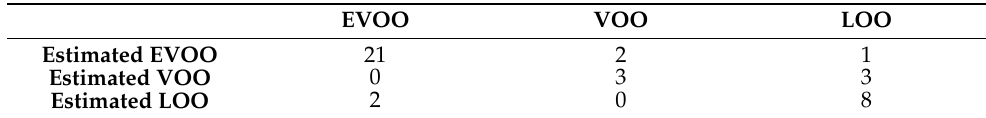
Table 6. Results of the KNN test in the case of three quality grade classes (EVOO, VOO and LOO) and both the HAS and DW reagents.